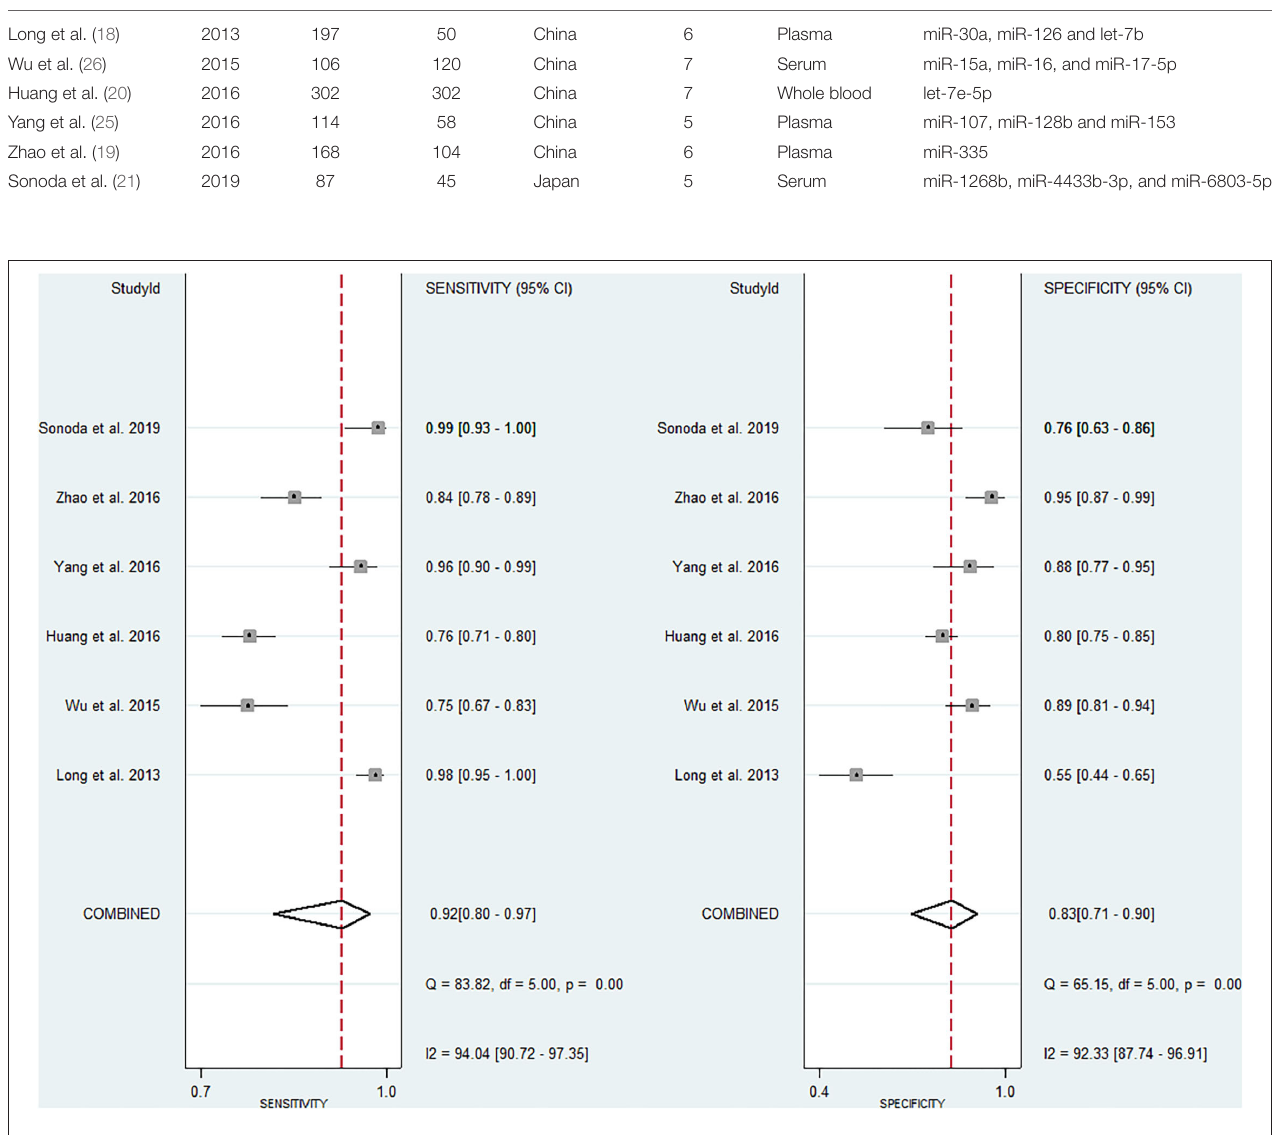
FIGURE 2 | Forrest plot of estimates of sensitivity and